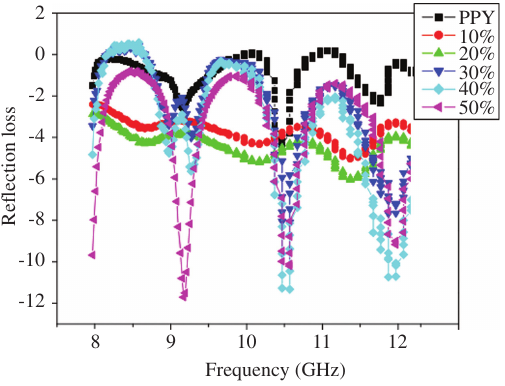
Figure 5 Reflection loss as a function of applied frequency for dif- ferent weight